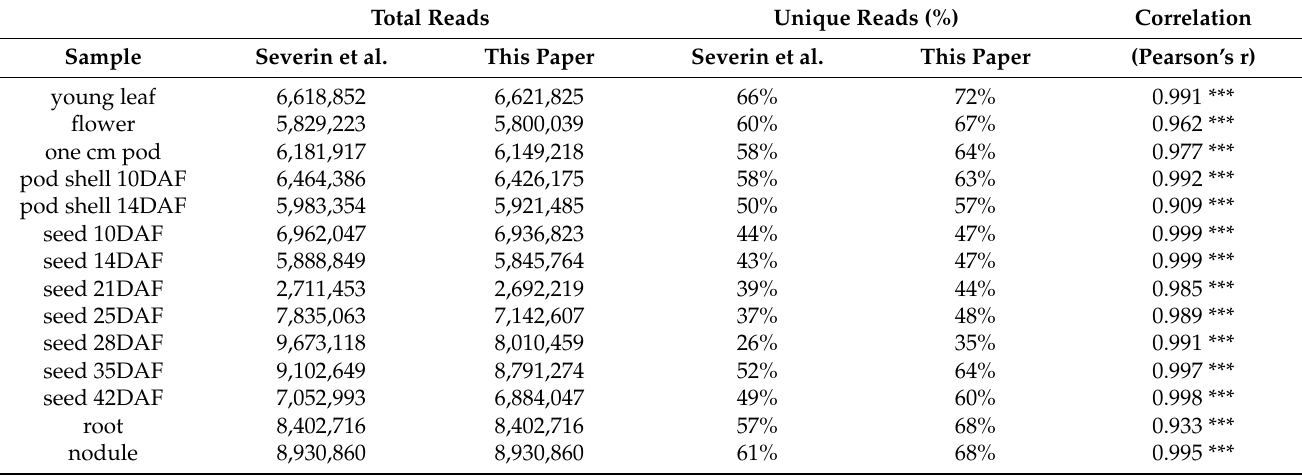
Figure 3. Schematic representation of the bioinformatics pipeline and workflow for high-throughput RNA-seq data re-analysis used in this paper. Each raw publicly available FASTQ file is downloaded from the database using the command line utility Wget, FASTQ files are trimmed on quality using Sickle, reads are mapped on the reference genome Wm82.a2.v1 and sorted into BAM files by STAR, HTSeq counts the gene expression reads per gene into an HTSeq-count matrix, count matrices per experiment serve as input for DESeq analysis or can be normalized by calculating the RPKM, finally DESeq result tables or RPKM tables can be further statistically analyzed or graphically visualized using R. Table 2. Comparison between the original gene expression atlas data and the re-analysis using the bioinformatics pipeline from this paper [31]. Total reads and % uniquely mapped reads per plant sample are given. In addition, the Pearson’s correlation coefficient was calculated for all gene expression counts within each sample. (*** = p <